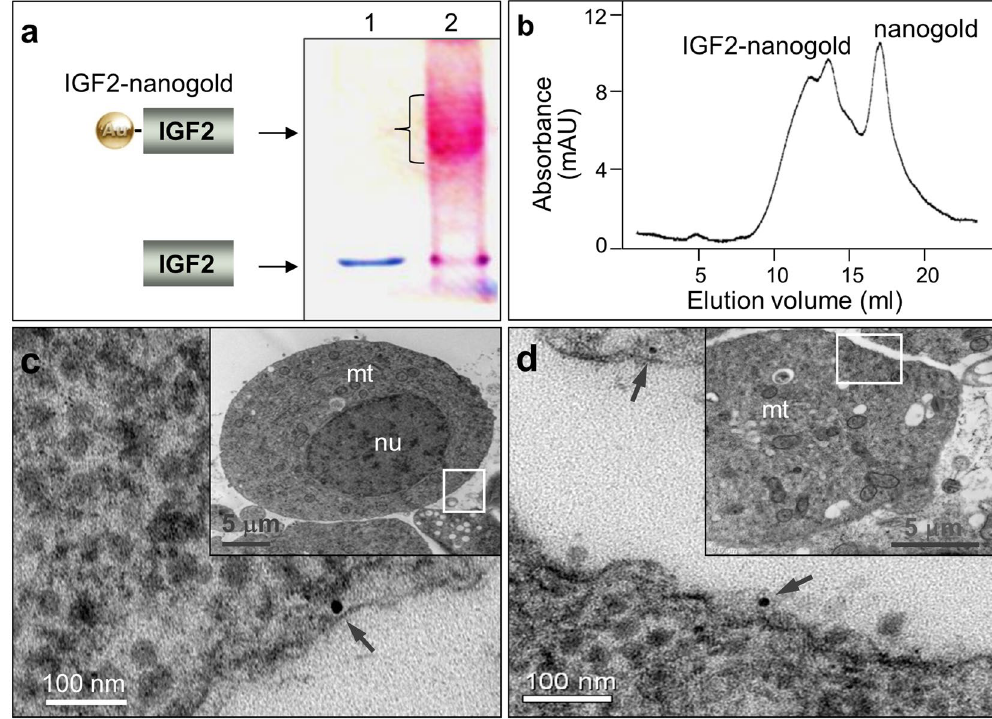
Figure 6. Location of IGF2 on the cell membrane. IGF2 was conjugated with nanogold and incubated with medaka blastomeres. Under electron microscopy, the ligand was detected on the cell surface or beneath the membrane. ( a ) 10% SDS-PAGE analysis of non-reduced and unboiled IGF2 (lane 1) and IGF2-Nanogold conjugate (lane 2). IGF2 was incubated with 1.4 nm nanogold, and the production was analyzed with SDS- PAGE. The protein band migrated at a higher apparent molecular weight after incubation with Nanogold (lane 2), demonstrating covalent attachment of 1.4 nm nanogold to IGF2. ( b ) Purification of IGF2-Nanogold conjugate with gel filtration. ( c and d ) Location of IGF2-nanogold under TEM, showing IGF2-nanogold (arrow) binding to cell. Insets depict the nucleus (nu), mitochondrial (mt) and location of enlarged areas of cells